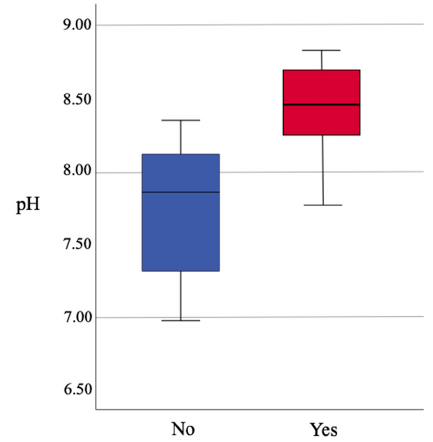
Insects 2021 , 12 , x FOR PEER REVIEW Figure 2. Boxplot comparing water pH to presence/absence of Vanuatubasis . Figure 2. Boxplot comparing water pH to presence/absence of Vanuatubasis .